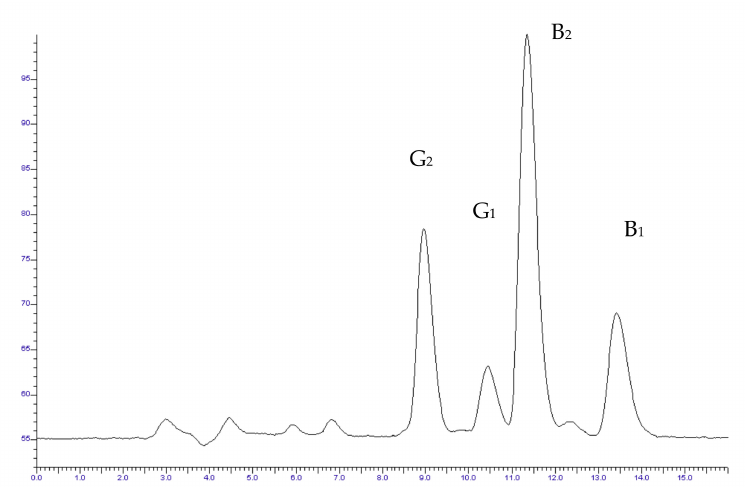
Figure 2. Typical chromatogram of standard solution of examined aflatoxins (G 2 , G 1 , B 2 , B 1 ) at the concentration of 1 µ g · L − 1 .